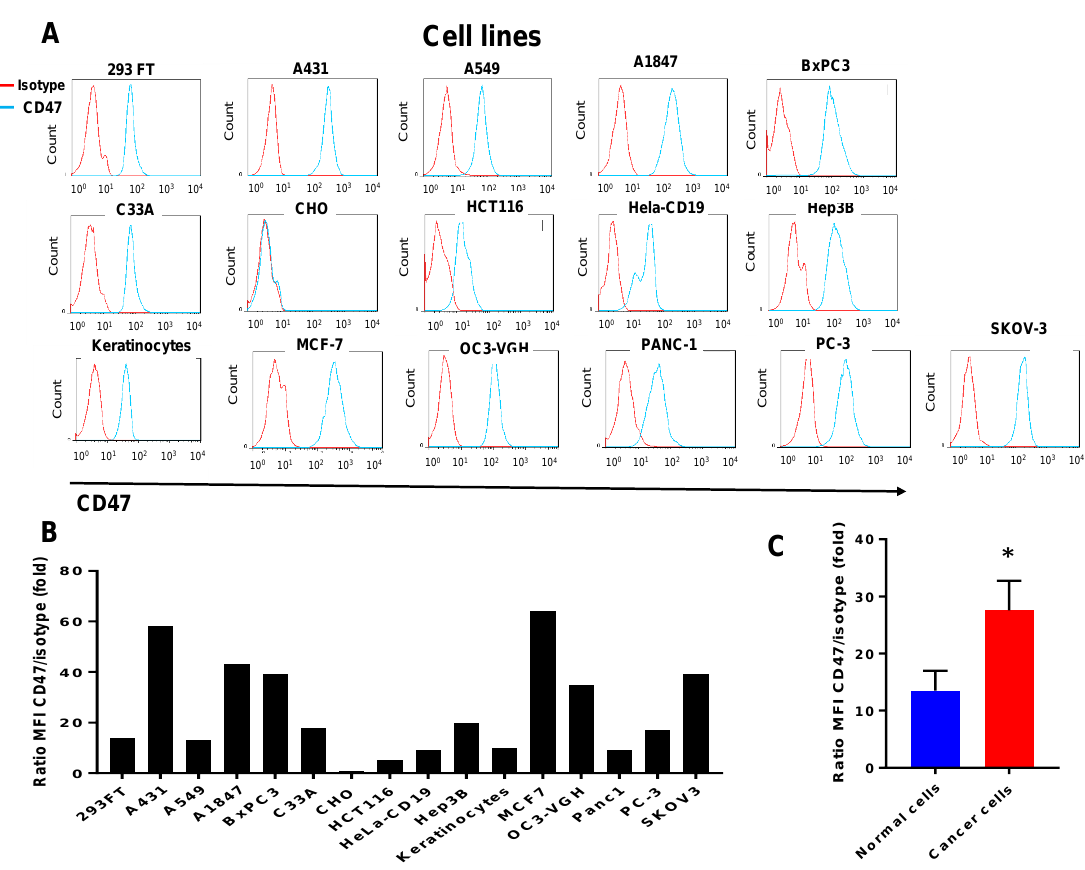
Figure 1. Variable expression of CD47 in different cell lines. ( A ) The FACS staining was done with CD47 (B6H12) (BioLegend, San Diego, CA, USA) antibody at 10 μ g/mL as described in Materials and Methods. Different cancer cell lines, as well and normal cell lines—keratinocytes, 293FT and CHO cell lines—were analyzed. The representative FACS plots from one to six independent experiments are shown; ( B ) Quantification of MFI to isotype control is shown. The MFI quantitation of data presented on Figure 1A show ratio of CD47 staining to isotype control; ( C ) Cancer cell lines express significantly higher levels of CD47 than normal cells. The bars show average ratio MFI CD47 staining to isotype control in human cancer cell lines and normal cell lines +/− standard errors from above experiments. * p = 0.023, Student’s t -test. Please define.